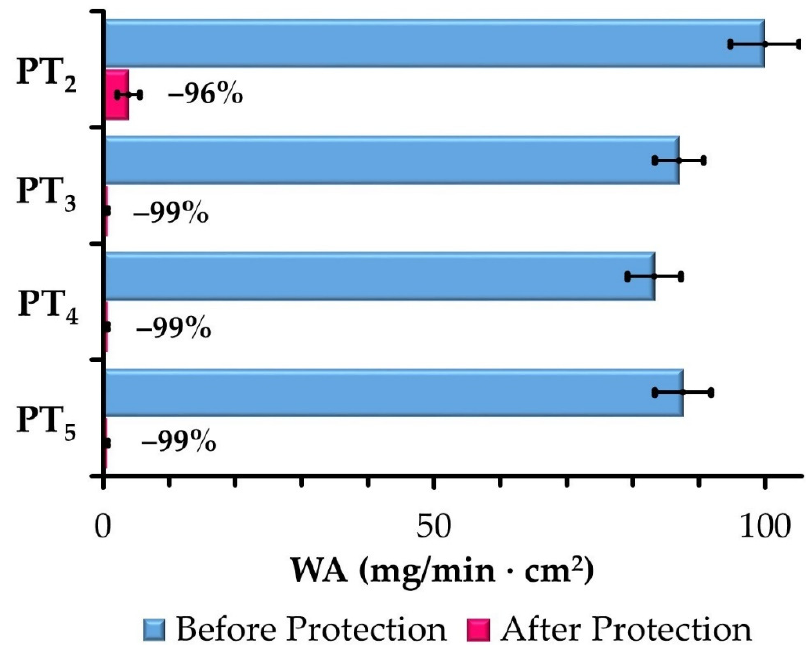
Figure 3. Water absorption by “contact sponge” test (WA) before and after the application of the protective treatments; the variation in percentage is also reported.